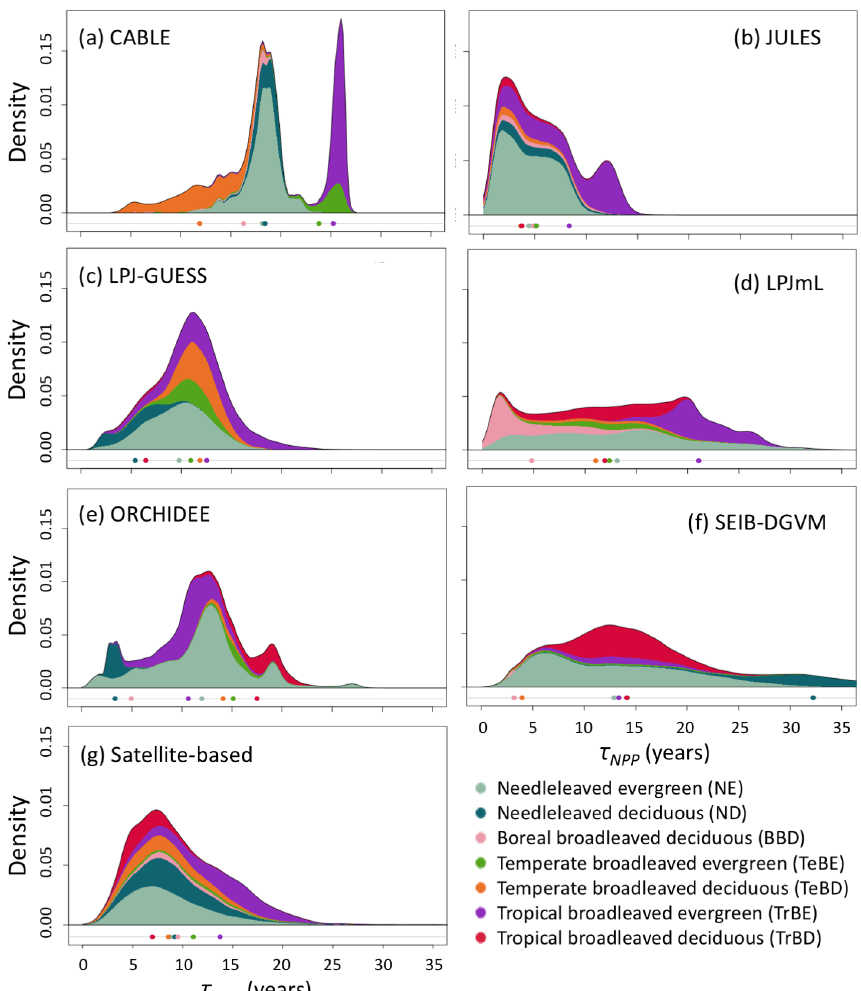
Figure 2. Probability density distributions for τ NPP for the period 1985–2014 under CRU-NCEP climate calculated by forest type (see “Methods”) and superimposed to produce a global probability density distribution. Density is defined as fraction of total grid-cell number, including all grid cells with at least 10% forest cover (i.e. masking as for Fig. 1). For the models, τ NPP was derived from entire grid cell C veg and forested-area-weighted NPP, as for the satellite-based product (see Sect. 2.4). Circles underneath distributions show the mean turnover time for each forest type after weighting by the forest cover fraction of the grid cell and excluding grid cells with less than 10% forest cover (see Table S1 for forest-type definitions). For the satellite-based probability density distributions the observationally based forest types (Table S3) were used, with broadleaved–needleleaved mixed forest (MX) assigned to BBD and excluding other tropical forest (OTr) and other forest (Other) because no equivalent categories were reported for the